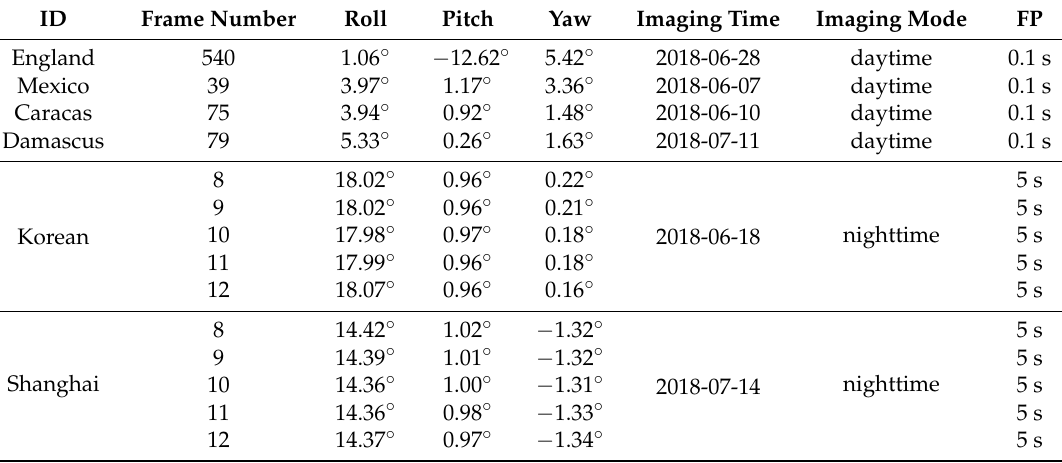
Table 3. Imaging information of experimental data.